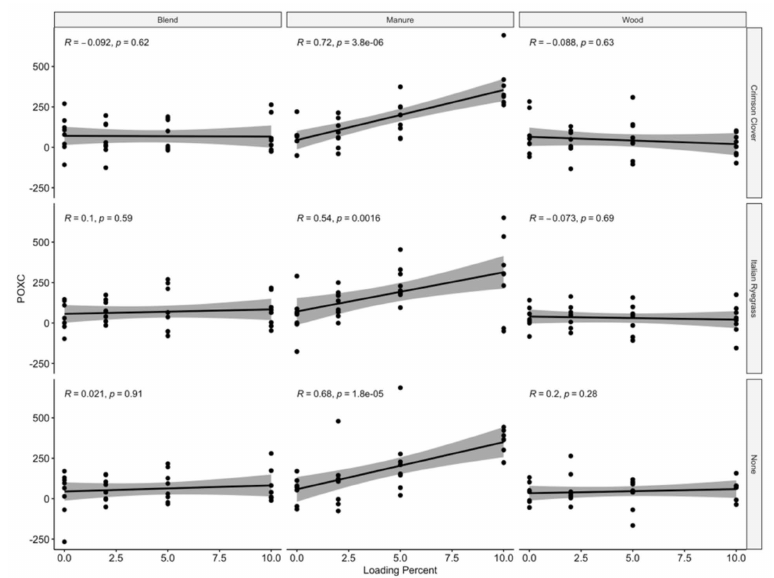
Figure 8. Soil oxidizable C (ppm) × Loading Percent, Spearman’s correlation for forage by BC type.